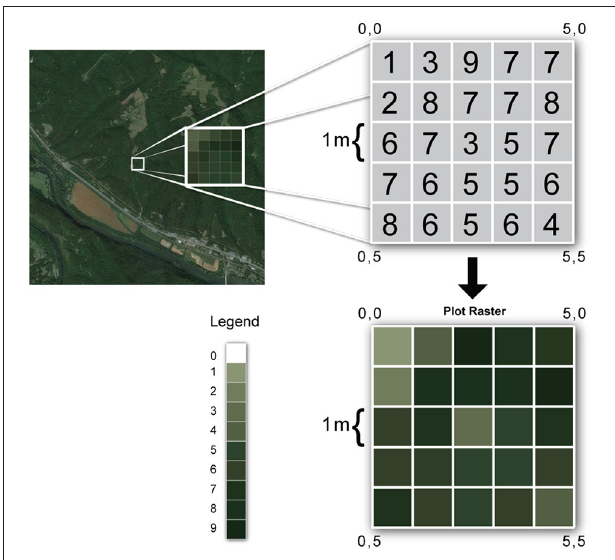
FIGURE 3 | Raster concept (Laurini and Thompson,